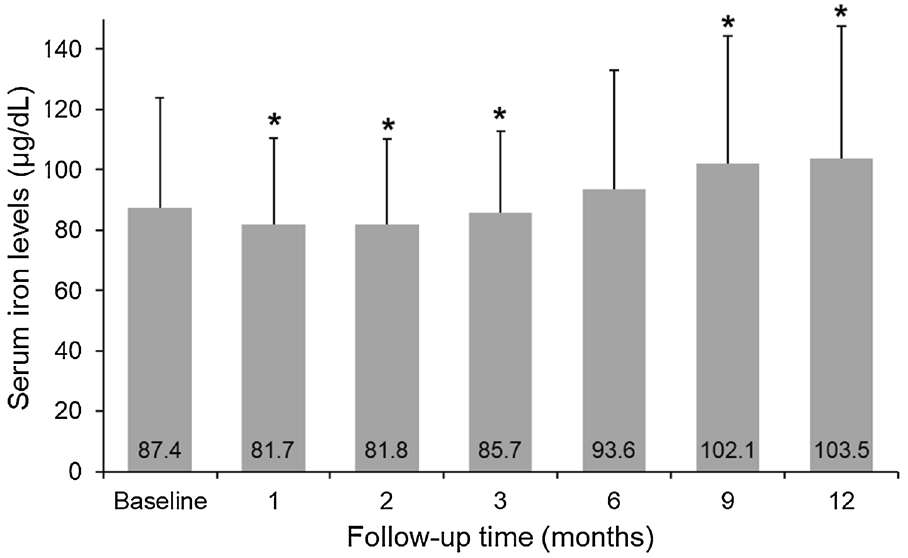
Figure 3. Change in serum iron levels at different timepoints after laparoscopic sleeve gastrectomy.